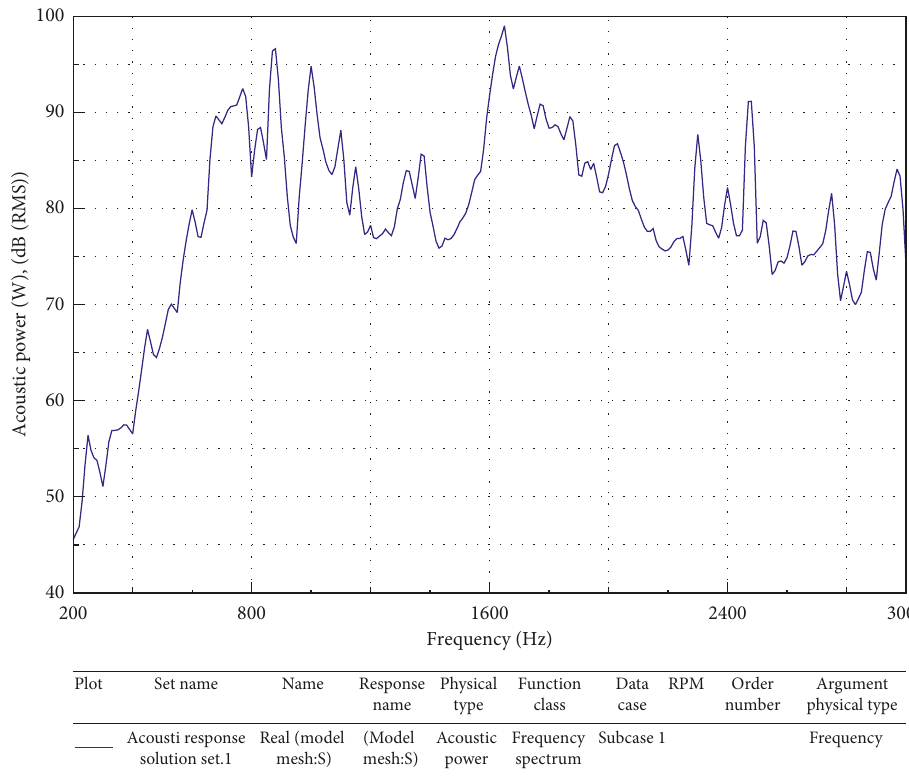
Figure 9: Frequency spectrum of radiating acoustic power.